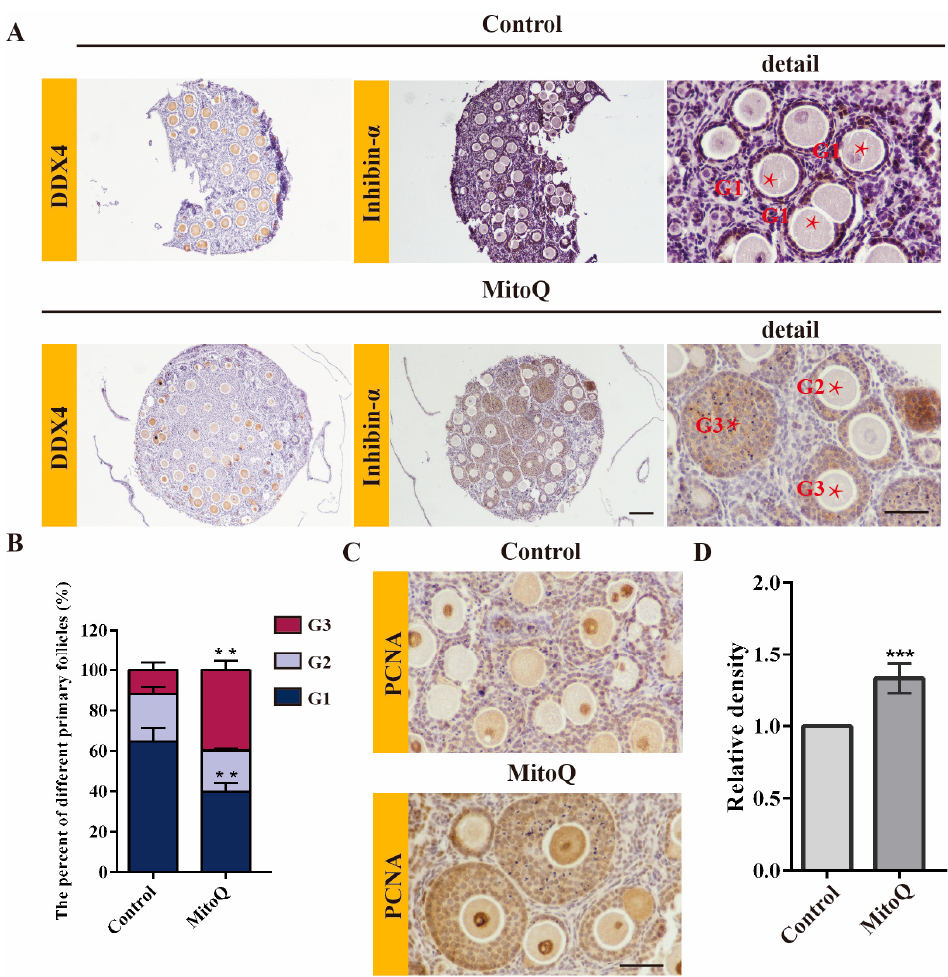
Figure 3. MitoQ promotes the proliferation of GCs during oogenesis in vitro. ( A ) Immunohistochemical detection of DDX4 and INHIBIN- α in ovarian organoids after 21 days of culture. Scale bar, 100 μ m (left), 50 μ m (right). ( B ) The percentage of different grade follicles on the organoid (n = 3). Grade 1 (G1): an oocyte surrounded by a monolayer of GCs; Grade 2 (G2): an oocyte surrounded with two layers of GCs; Grade 3 (G3): like Grade 2, but with more than three layers of GCs with the larger size. Error bars indicate SD. ** p < 0.01, vs. control group. ( C ) Immunohistochemical detection of PCNA in ovarian organoids (5 sections per organoid, n = 3). Scale bar, 50 μ m. ( D ) The relative intensity of PCNA. Error bars indicate SD. *** p < 0.001, vs. control group. All sections were 3–5 μ m serial sections.